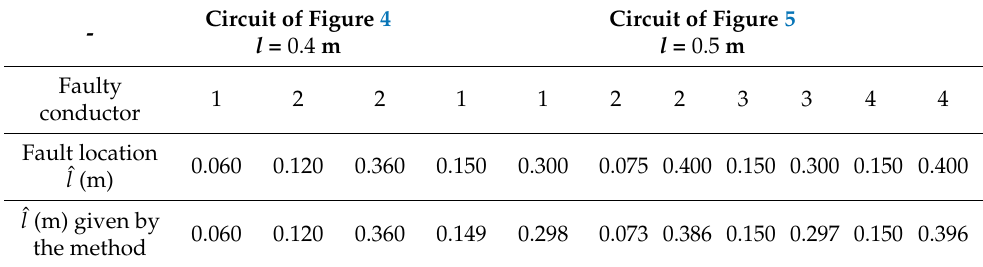
Table 4. Results of open faults diagnoses in the circuits of Figures 4 and 5.